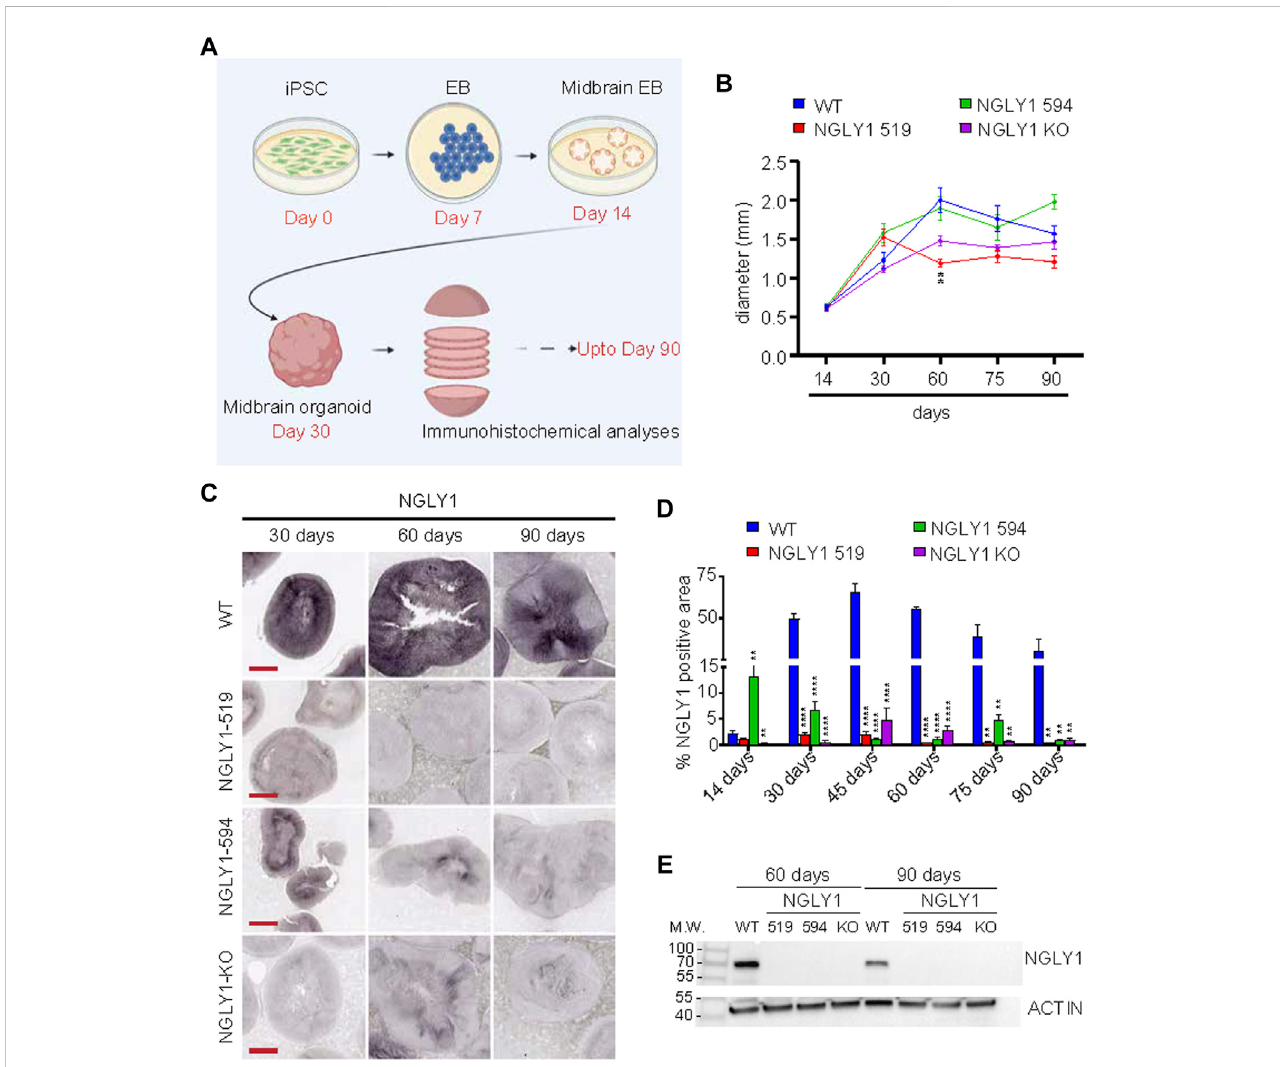
FIGURE 1 NGLY1disease midbrain organoidsdonot expressNGLY1 protein. (A) Aschematicshowing thedifferentstages ofmidbrain organoid development. (B) A graph showing changes in midbrain organoid size, presented as diameter (mm) through development and maturation. (C) Representative images using bright fi eldmicroscopyformidbrainorganoidsstainedwithantibodyagainstNGLY1atdifferenttimepoints(45,60and90days).Scalebars:500 µM. (D) Graph showingpercenttotalNGLY1positivesignalindifferentorganoidsatdifferenttimepoints. (E) ArepresentativewesternblotshowingNGLY1expressionin cell lysates obtained from control and NGLY1 disease midbrain organoids. Statistical signi fi cance determined by multiple t -test analysis denoted by * = ( p ≤ 0.05), ** = ( p ≤ 0.01), *** = ( p ≤ 0.001), **** = ( p ≤